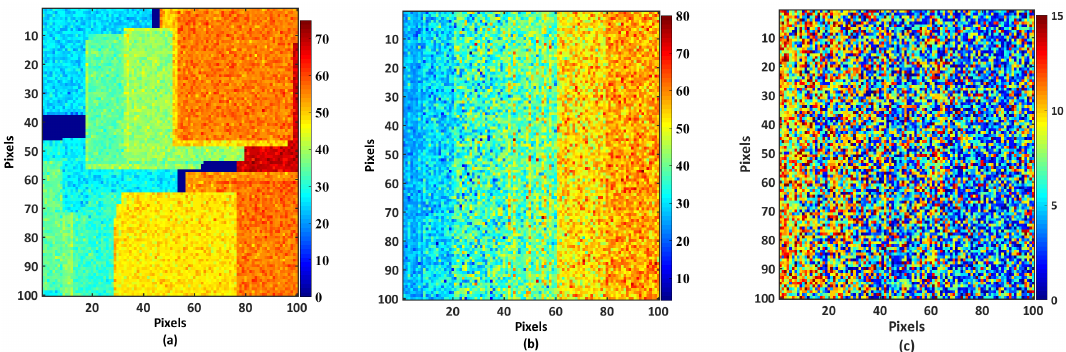
Figure 11. Visibility estimates at the sixth iteration with 30 dB correlated noise ( a ) before and ( b ) after binning; and ( c ) pixelwise absolute differences between ( b ) and the true visibilities of Figure